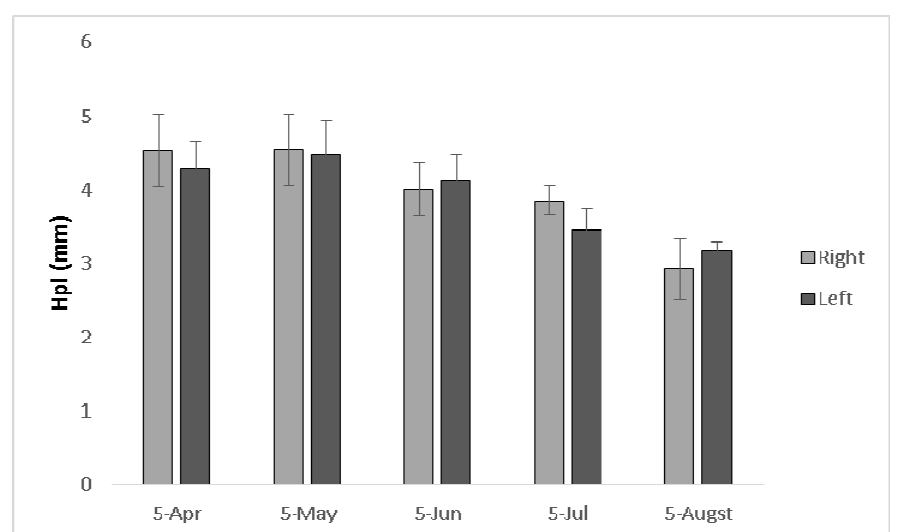
F IGURE 8. Mean of hemipenis length (HpL) of Teratoscincus bedriagai from April to August 2013. to November and the peak of spermatogenesis was in May and June. All lizards of the study area hibernated from October or November to March. In T. bedriagai , most of testicular parameters were observed in minimum size in August. In comparison with other lizards of Iran, these two sympatric geckos, Teratoscincus bedriagai and Tenuidactylus caspius , start their reproductive activities earlier than other studied